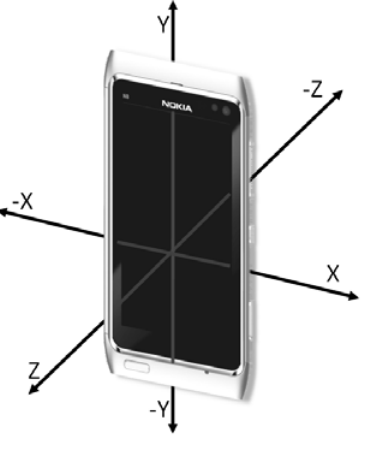
Figure 1. The smartphone body frame defined for the Nokia N8 consists of three axes and six directions, and it uses the right-hand Cartesian coordinate system. The various sensors all use the common body